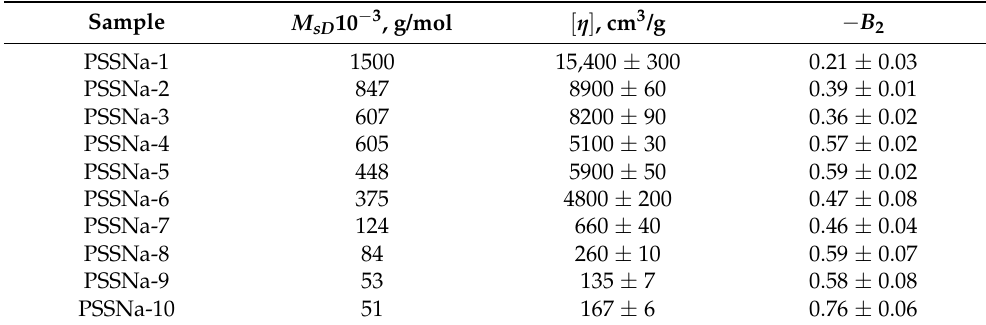
Table 5. The molecular masses M sD , the values of intrinsic viscosities [ η ] and parameters B 2 (Equation 4) for PSSNa in H 2 O at 25 ◦